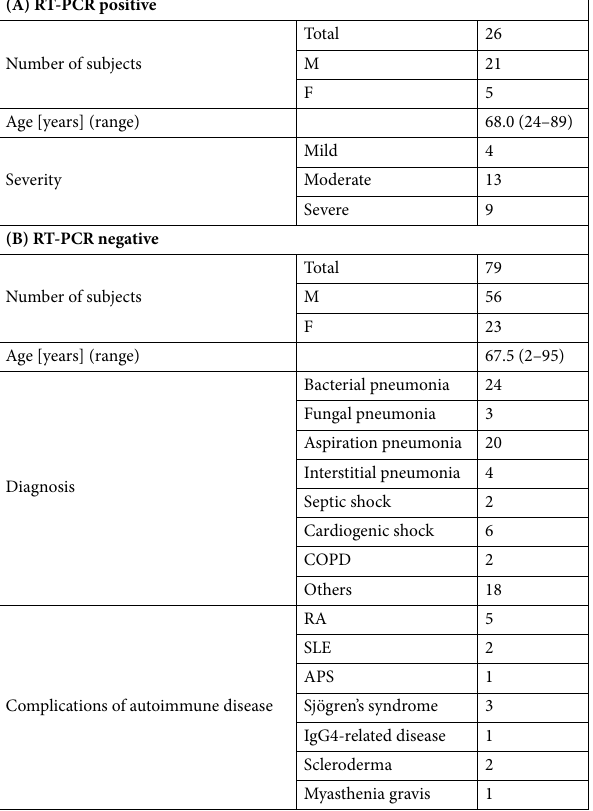
Table 2. Characteristics of the subjects. APS anti-phospholipid antibody syndrome, COPD chronic obstructive pulmonary disease, RA rheumatoid arthritis, SLE systemic lupus